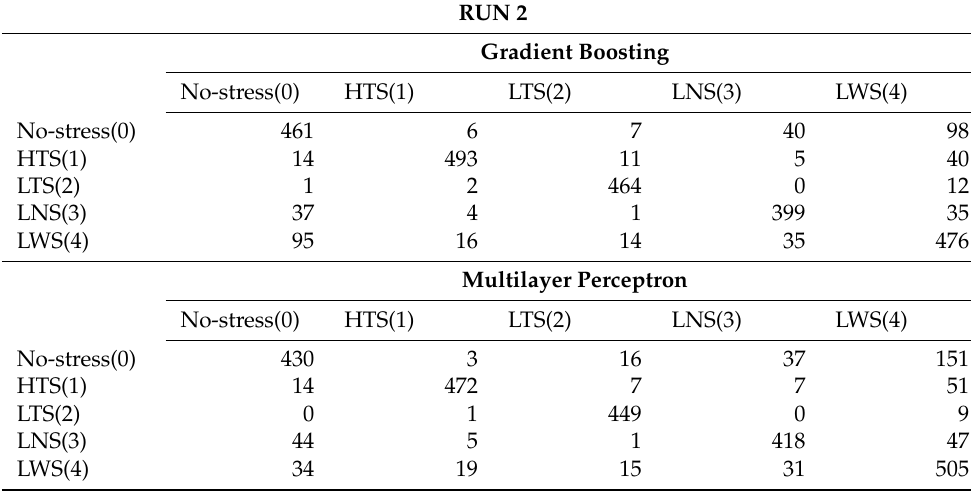
Table 2. The predicted category of the samples of each treatment for GB and MLP algorithm in the RUN 2 test process (of testing sample